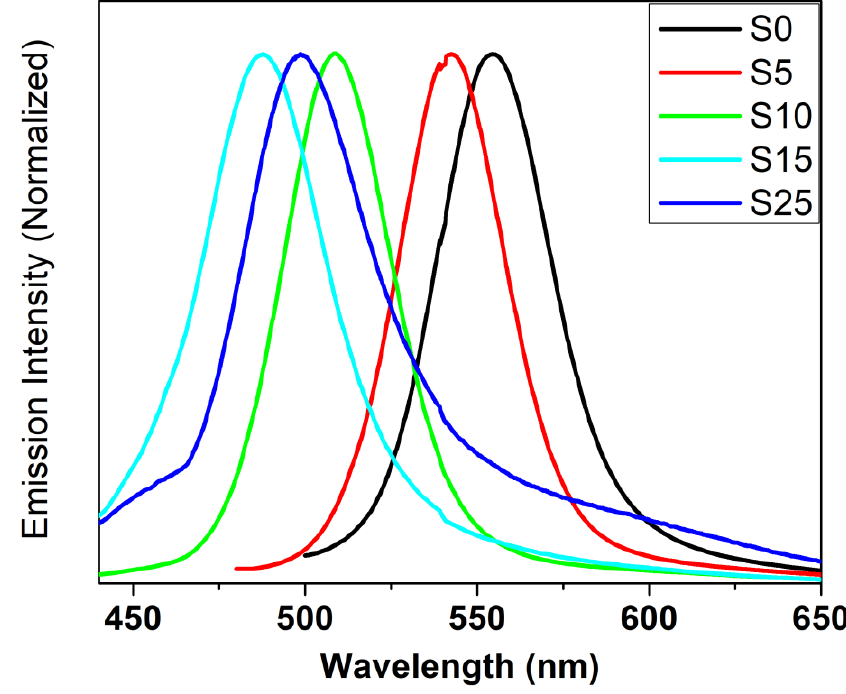
Figure 13. Normalized luminescence spectra of the CdSSe alloyed structure with different compositions.